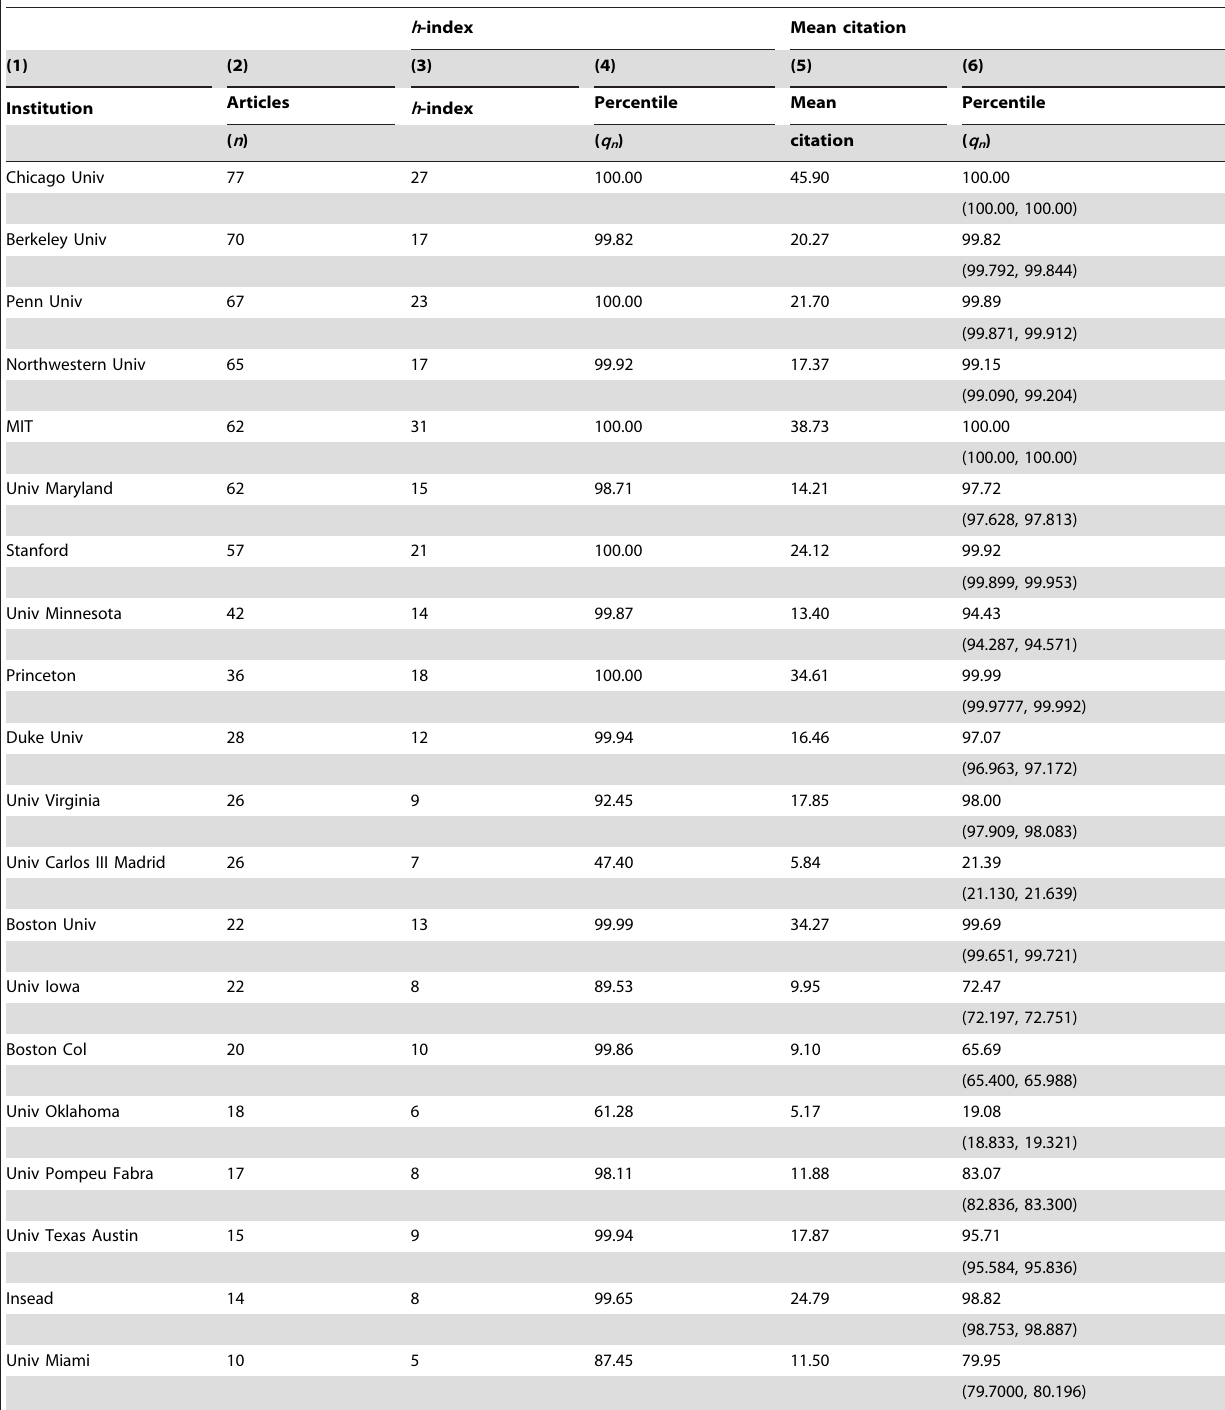
Table 4. Sub-field of